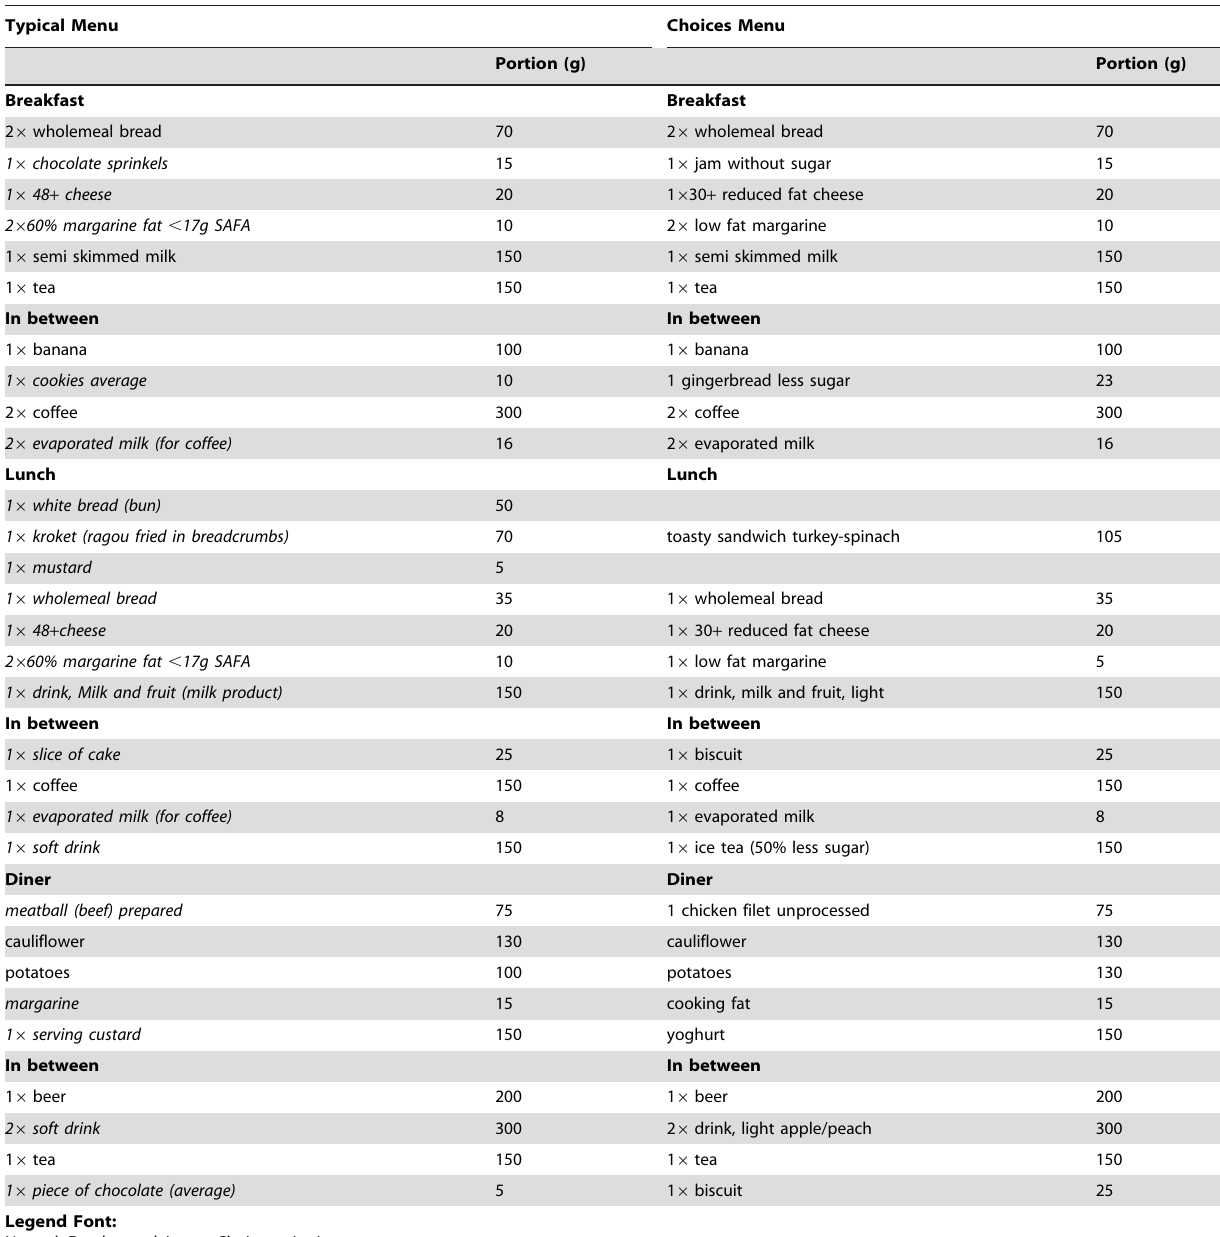
Table 3. Example of one single Daily Menu from The Netherlands.*